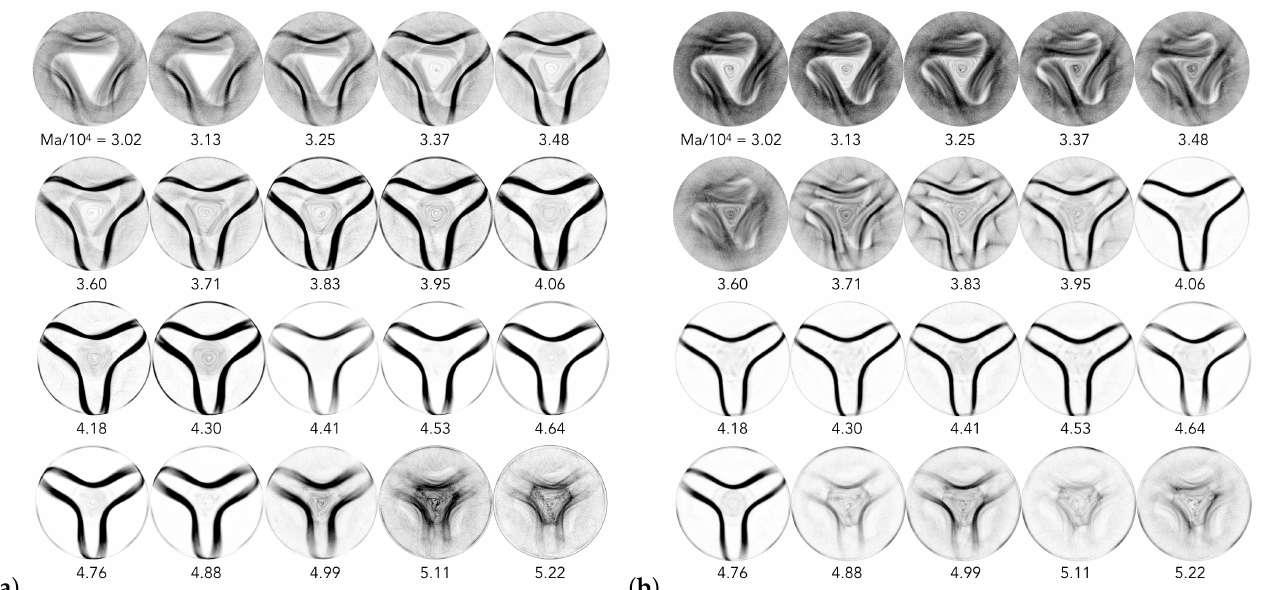
Figure 5. Variations of coherent structures by the particles as a function of Ma for ( a ) d p = 15µm and ( b ) d p = 30µm. Conditions are the same as indicated in Figure 4. The azimuthal direction of the thermal wave over the free surface due to the HTW is counterclockwise for all images. Ma is evaluated by applying H for the characteristic length L . ( Figure 5 in Gotoda et al.